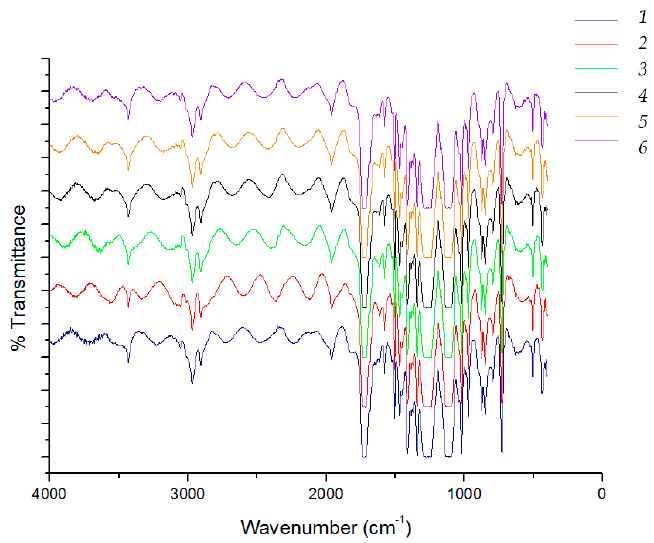
Figure 7. FT-IR spectra of PET in the recovered separated films after washing with Alcalase.